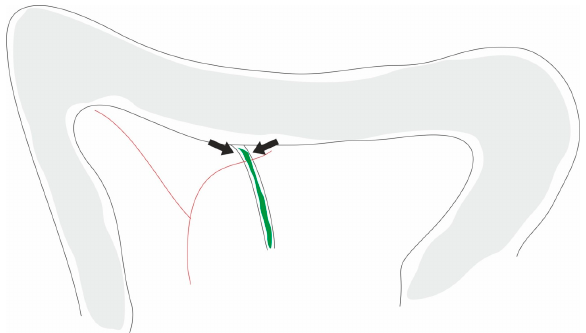
Figure 4. Image: picture showing the site of ligation of the common biliopancreatic duct in the rat. According to aseptic techniques, the duodenum is exposed by a laparotomy; the common biliopancreatic duct is identified and ligated at the level of the duodenum (arrows).